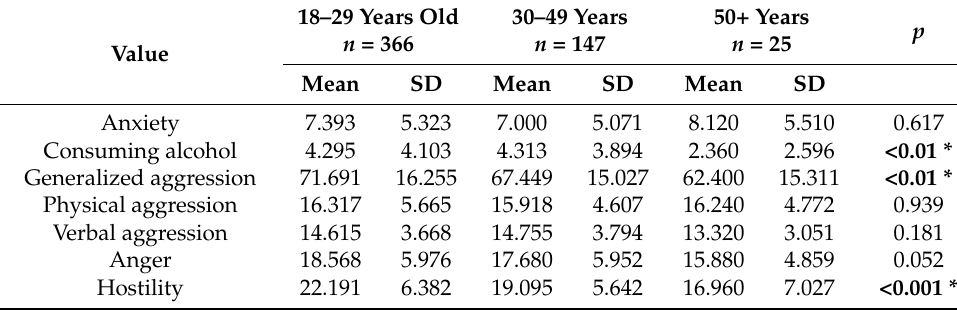
Table 4. Differences between age groups concerning the parameters tested.